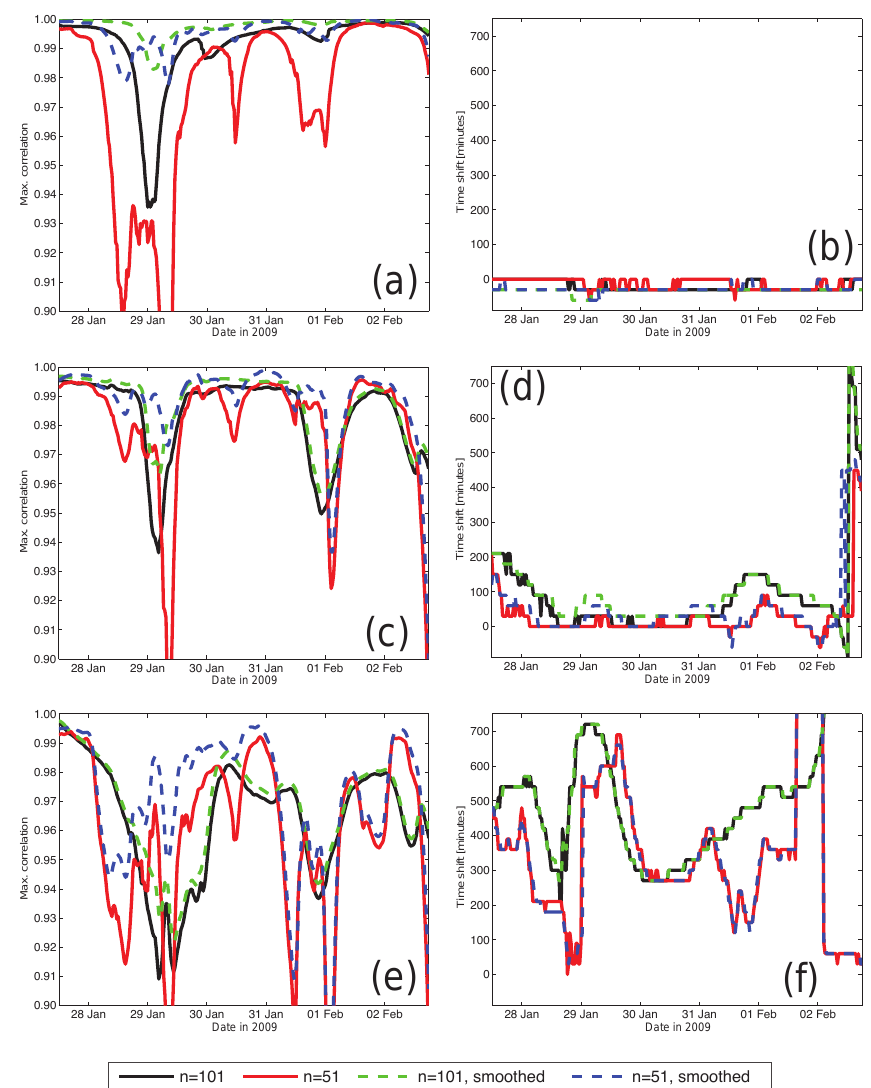
Figure 8. Epoch-wise maxima of correlation (left panels) and corresponding time shifts (right panels) for the three pairs of loggers T1:T2 (top panels), T1:T3 (middle panels), and T1:T4 (bottom panels); for smoothing the centered moving mean of five samples was